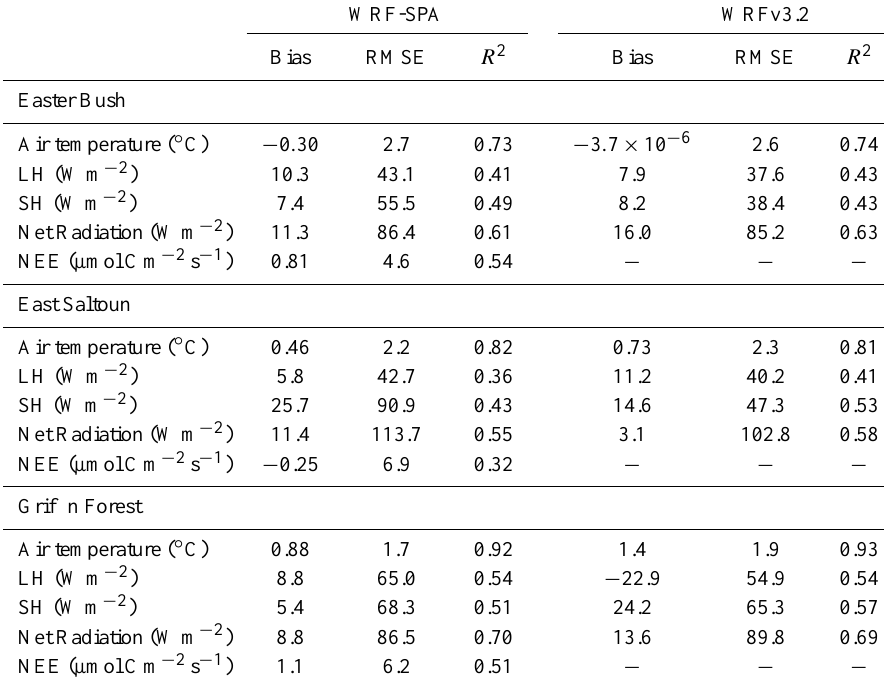
Table 3. Summary of WRF-SPA and WRF multi-annual statistics for surface validation sites during 2004–2005 (East Saltoun and Easter Bush) and 2005–2006 (Griffin Forest). Statistics are for hourly observations of the surface air temperature, net ecosystem exchange (NEE) (WRF-SPA only), latent (LH) and sensible heat (SH) fluxes. Statistics are mean annual bias, root mean square error and R 2